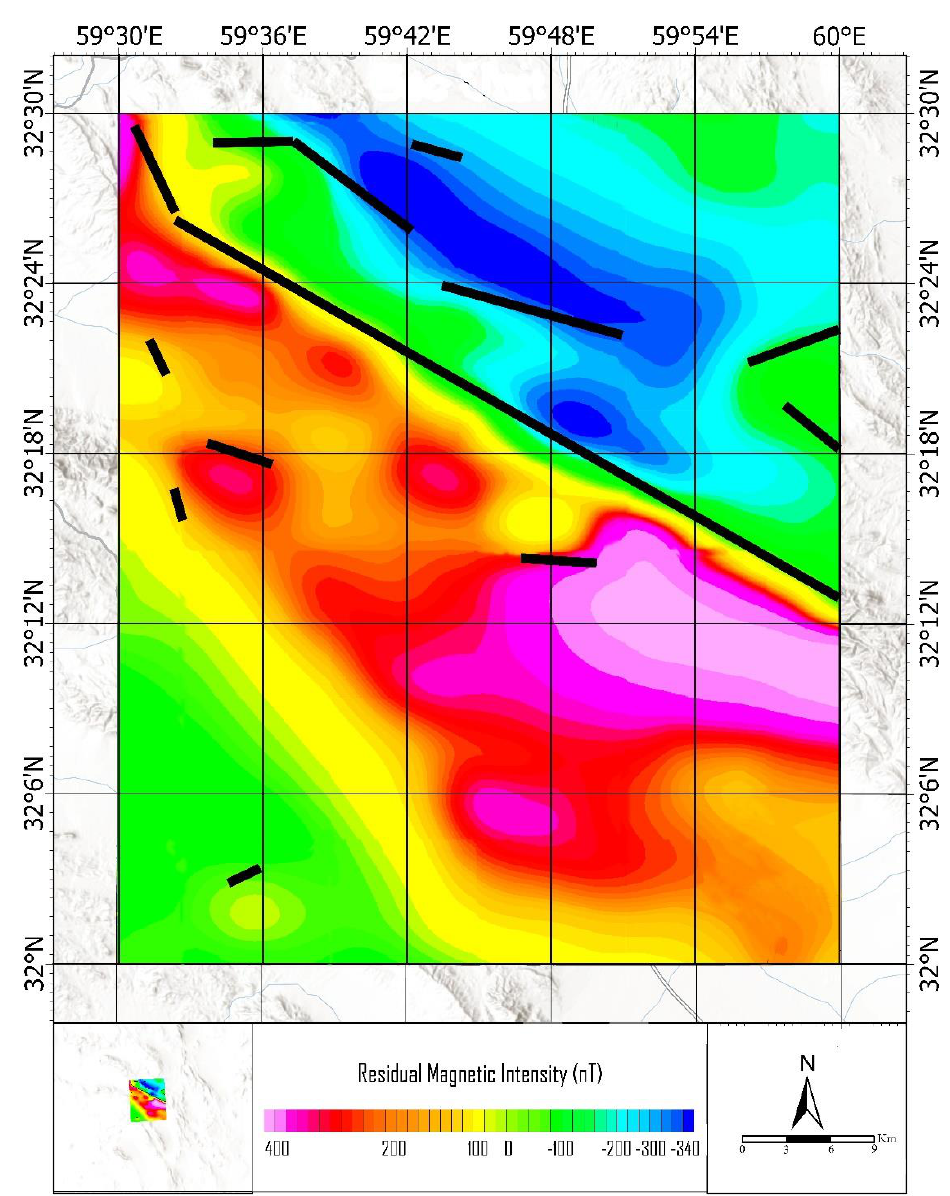
Figure 7. Map of changes in residual magnetic field intensity and faults identified by airborne magnetometry in the Sahlabad area.